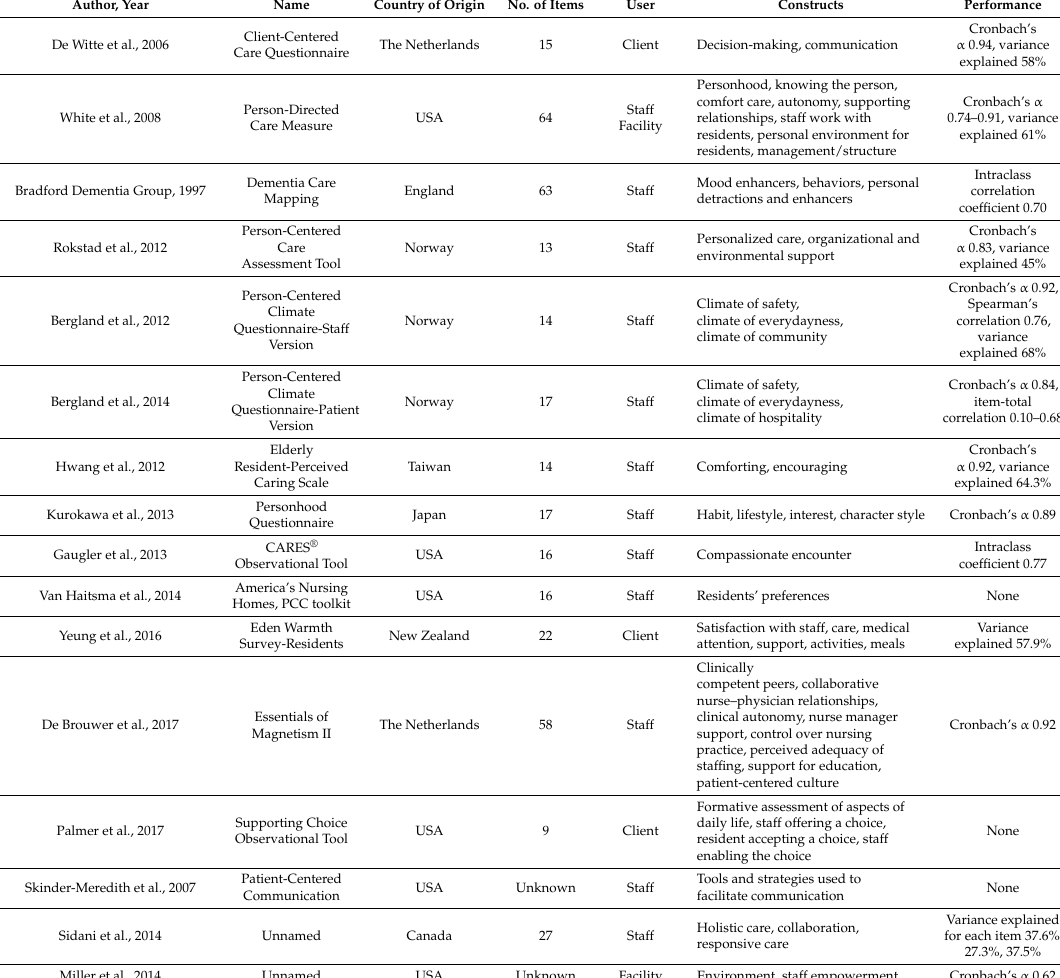
Table 1. Person-Centered Care Tools for Use in Long-Term Care/Nursing